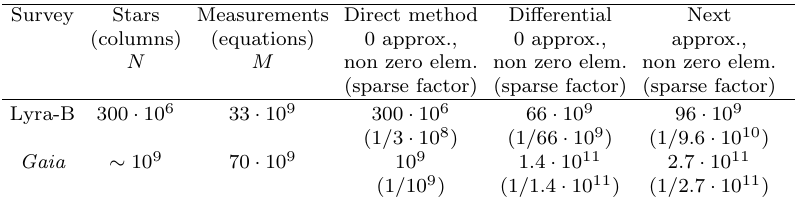
Table 2. Parameters of normal equations for sparse matrices for two surveys. Survey